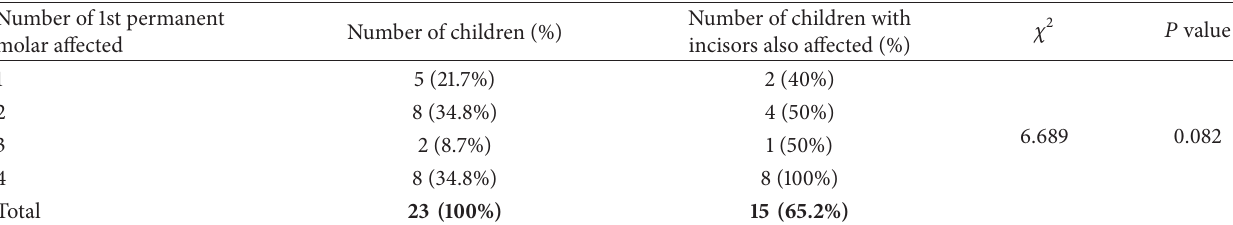
Table 4: Prevalence of MIH by type of